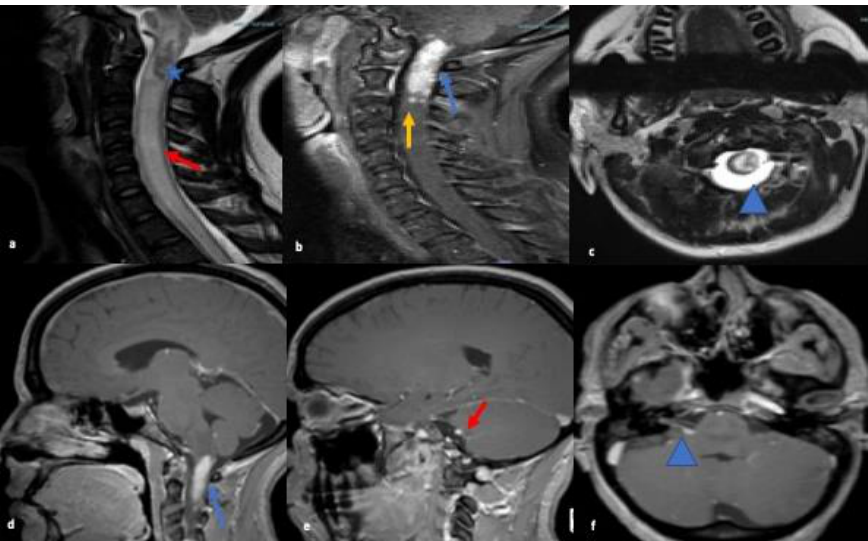
Figure 1. MRI sagittal T2 images ( a ) of the cervical spine reveal ill-defined long segment signal alteration with prominent cord expansion (red arrow) and ill-defined heterogenous lesion in cer- vicomedullary junction of the cord (blue asterisk); and ( b ) T1 post contrast image shows cord enhancement (blue arrow) and multiple separated subtle foci of enhancement were noted at C3 (yellow arrow). Axial T2-weighted ( c ) reveals corresponding hyperintense cord signal (blue arrow- head). MRI Brain sagittal and axial T1 post contrast images highlights homogenous enhancement at cervicomedullary junction (blue arrow; ( d )), and enhancement along CN VII and VIII nerve complex (red arrow; ( e )) & (blue arrowhead; ( f )). A lumbar puncture was performed, and relevant CSF findings included elevation of CSF protein of 77 mg/dl and cell count of 10 cells/mm 3 with predominant lymphocytes. CSF kappa free light chain was normal. Biopsy of the cervical intramedullary lesion indi- cated granulomatous inflammation and no neoplastic or primary demyelinating process. Based on these findings, the patient was diagnosed with NS and was started on high dose Case (1 gm) IV methylprednisolone daily for five days. Patient showed some improvement in muscle strength on day 4 of treatment. She was discharged to inpatient rehab with con- tinuation of oral steroids (refer Table 1). Table 1. Clinical demographics, characteristics and Serum, CSF MRI findings and outcomes of patients with Neurosar- coidosis.